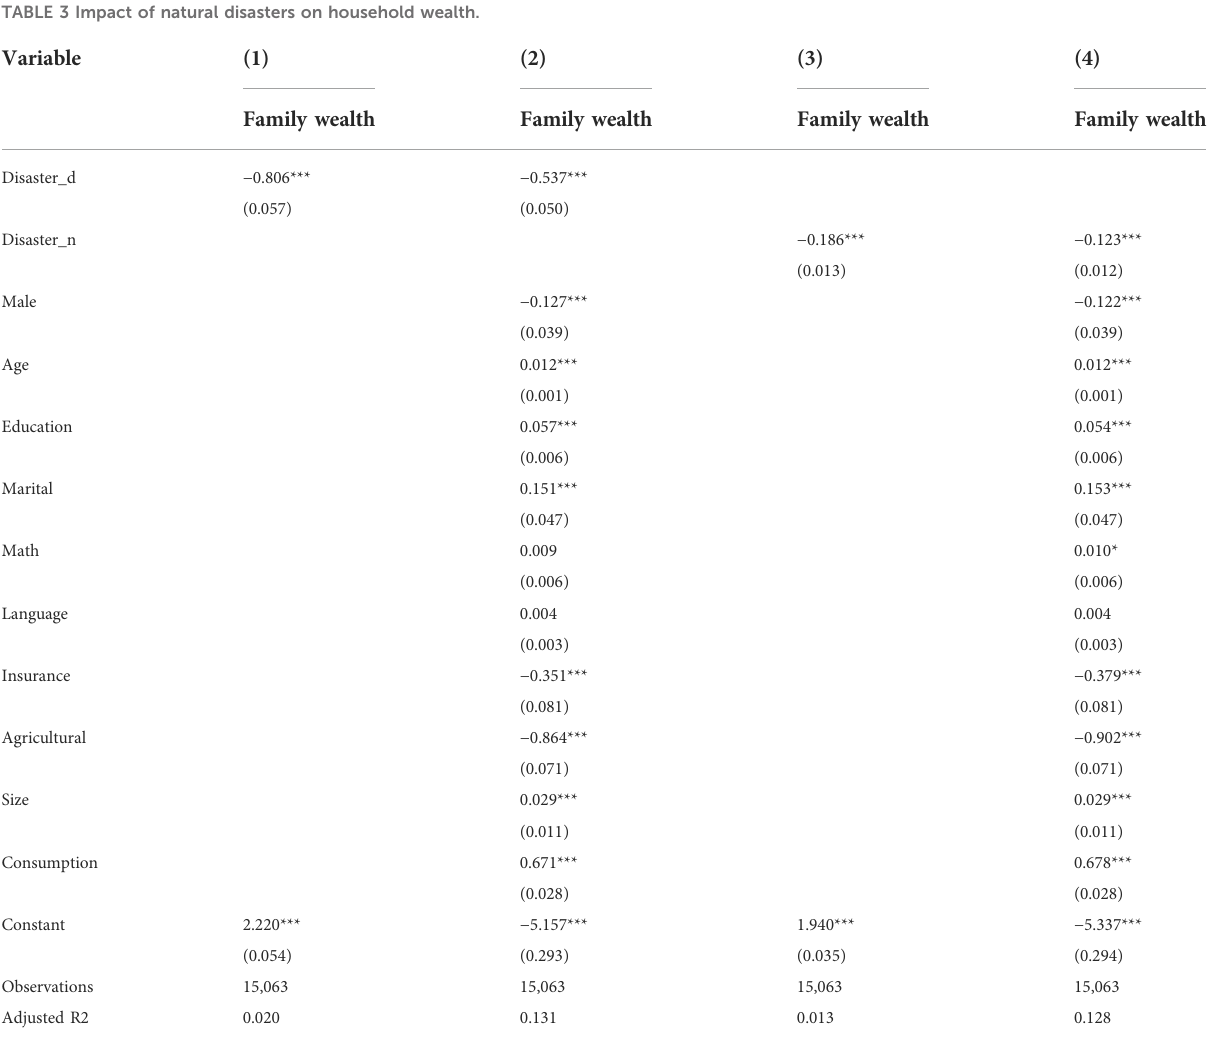
TABLE 3 Impact of natural disasters on household wealth.